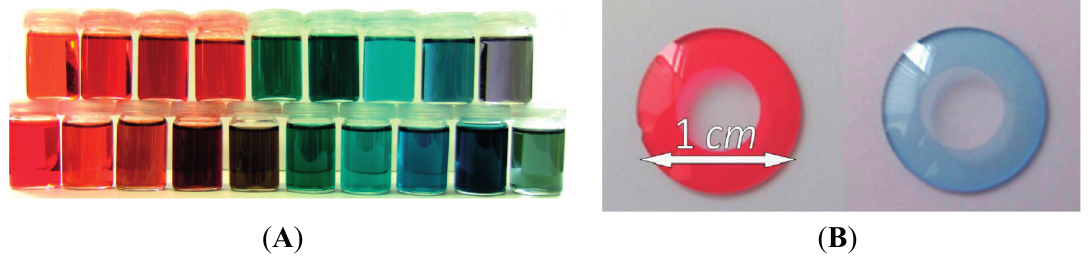
Figure 9. The broad color spectrum of mixed anthraquinone monomers ( A ) and the resulting iris implants after copolymerizing, crosslinking and sharpening the anthraquinone derivatives ( B ) [60]. Reprinted with the permission from Beilstein Journal of Organic Chemistry, 2013 , 9 ,